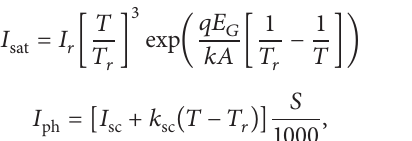
The MPPT is carried out in order to reach the peak point of nonlinear curve, the photovoltaic power system is connected to a boost converter, and the duty cycle of switch is controlled by the voltage and current generated by photovoltaic power system, so as to implement MPPT. The basic structure diagram [11–16] of the converter is shown in Figure 3. When the switch is “on,” the photovoltaic power system charges the inductor via the switch. When the switch is “off,” the photovoltaic power system releases the inductive energy to the load via diode. Adjusting the duty cycle changes input voltage and current, so as to change the output